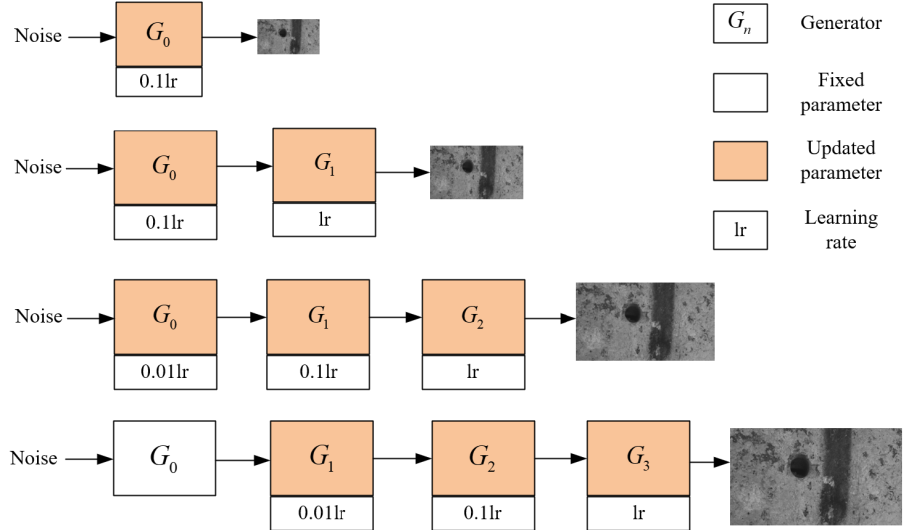
Figure 2. Changes of generator and its learning rate during model training.